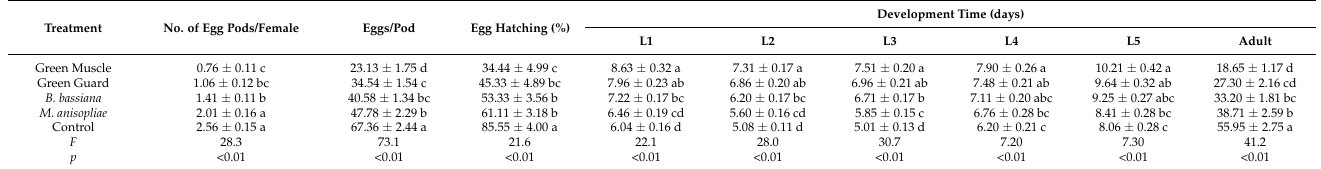
Table 1. Effects of applying one sublethal dose (1 × 10 4 conidia/mL) of Green Muscle, Green Guard, B. bassiana , or M. anisopliae to S. gregaria adults on the number of egg pods/female, number of eggs/pod, egg hatching, development time for offspring of different instars, and survival of resulting adults. Data are means ± SE, and within each column and treatment, different letters indicate significant differences (Tukey’s HSD test at p ≤